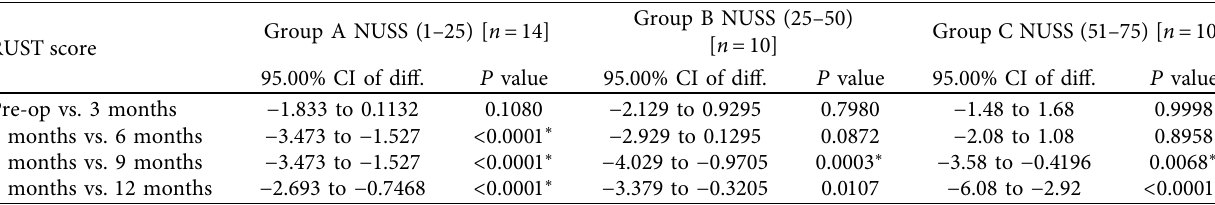
Table 2: Comparison of RUST score at serial follow-up.